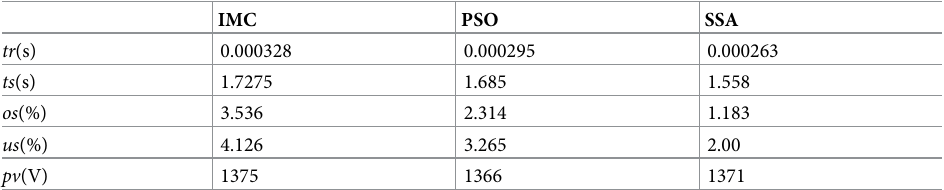
Table 7. DC link voltage